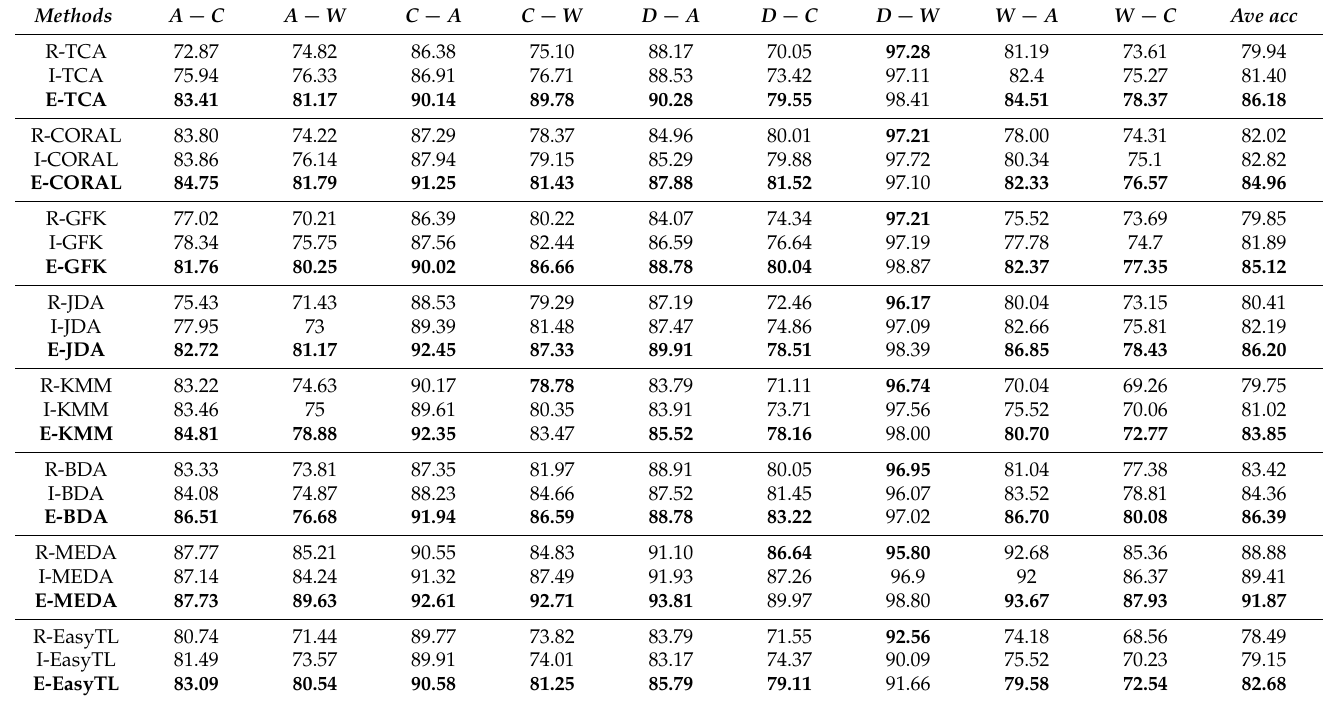
Table 6. Cross-domain classification accuracies of Office+Caltech image data sets generated